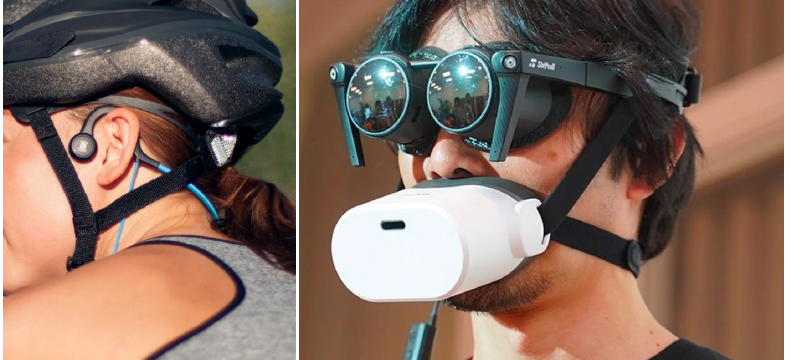
Figure 8. A bone conduction headphone using the bones in the jaw and upper cheek to transmit vibrations directly into the inner ear during playback ( left ) and Mutalk, the latest development for the Metaverse: a microphone with a mute function that prevents one’s voice from leaking out ( right ). Using a helmet instead of glasses will not leave space for further devices to be attached to the